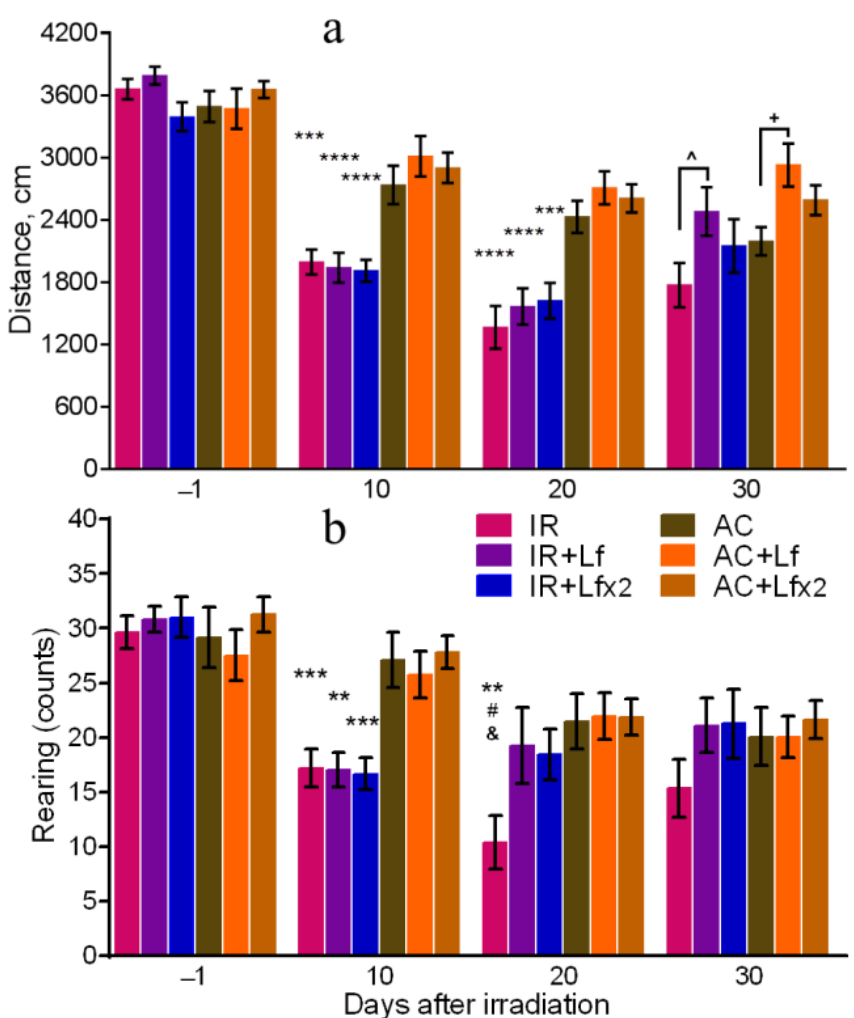
Figure 4. Effects of Lf on mouse behavior in the open field test after 7.5 Gy whole-body gamma irradiation. Lf (i.p.; 4 mg/mouse) was administered immediately after irradiation/sham-irradiation (IR+Lf, IR+Lf × 2, AC+Lf, AC+Lf × 2) and 24 h after it (IR+Lf × 2, AC+Lf × 2). Total distance traveled ( a ). Number of rearings ( b ). n = 32, 20, 20 (day − 1; for IR, IR+Lf, and IR+Lf × 2, respectively); n = 17 (for AC, AC+Lf, and AC+Lf × 2). Values are presented as mean ± SEM. ** p < 0.01, *** p < 0.001, **** p < 0.0001 in comparison with the corresponding control (sham-irradiated) groups on the same day; # p < 0.05 in comparison with the IR+Lf group, & p < 0.05 in comparison with the IR+Lf × 2 group on day 20. ˆ p < 0.05; + p < 0.05.